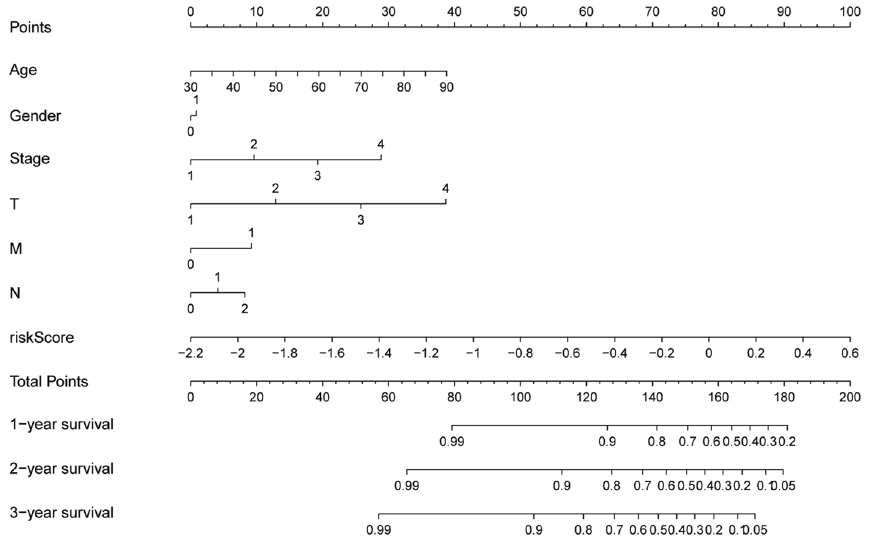
Figure 8. Nomogram was built to predict overall survival for colon cancer patients.